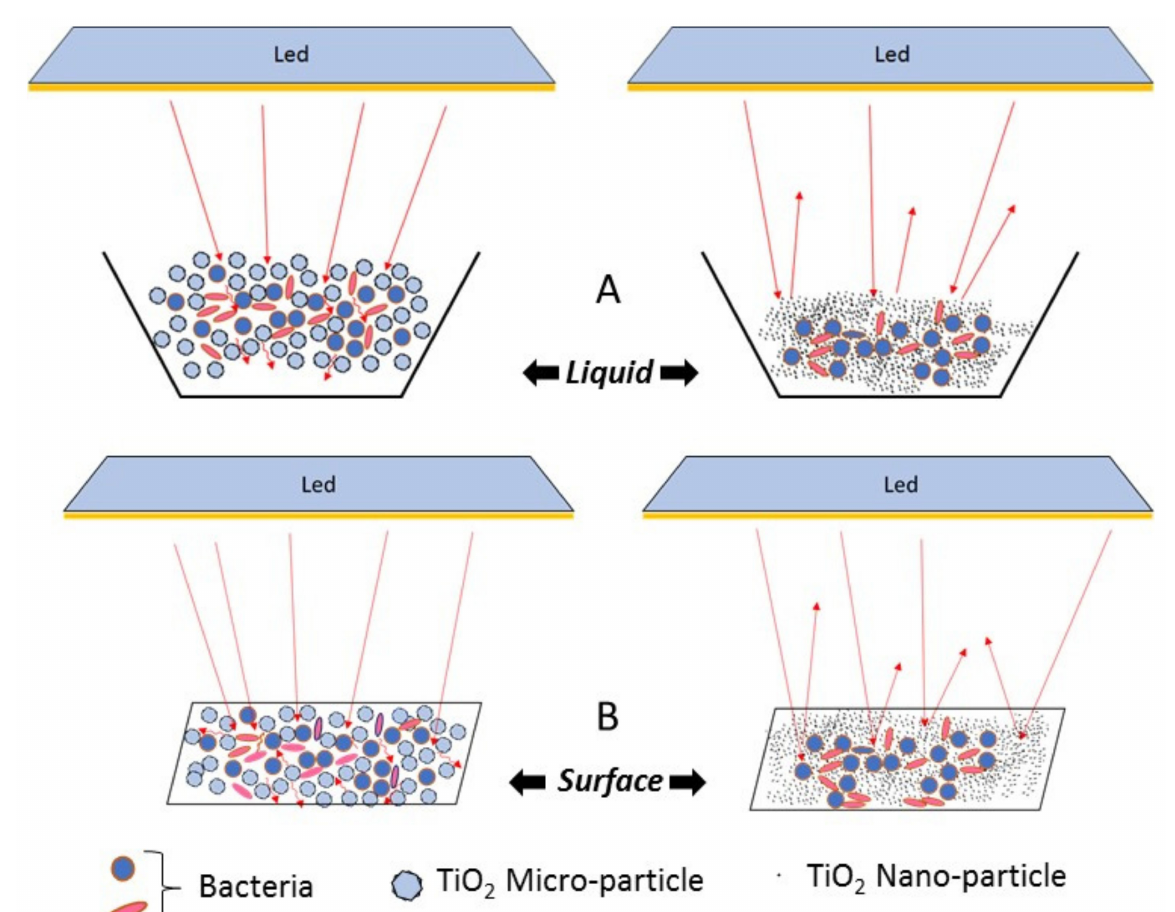
Figure 8. Hypothetical impact of granulometry on the light penetrance and photocatalytic interaction. Putative theoretical model to explain the enhanced effect of micrometric vs. nanometric particles. A reflexing-refraction interference and roughness may favor the interaction between light and microparticles, respectively, in a water suspension or on a coated surface. Specific strategies for fixing particles on a matrix (e.g., chitosan, polysilicon, or others reported in Table 2), may further enhance the light effect. Gram positive and Gram negative bacteria (1 µ m) are reported in blue and red,